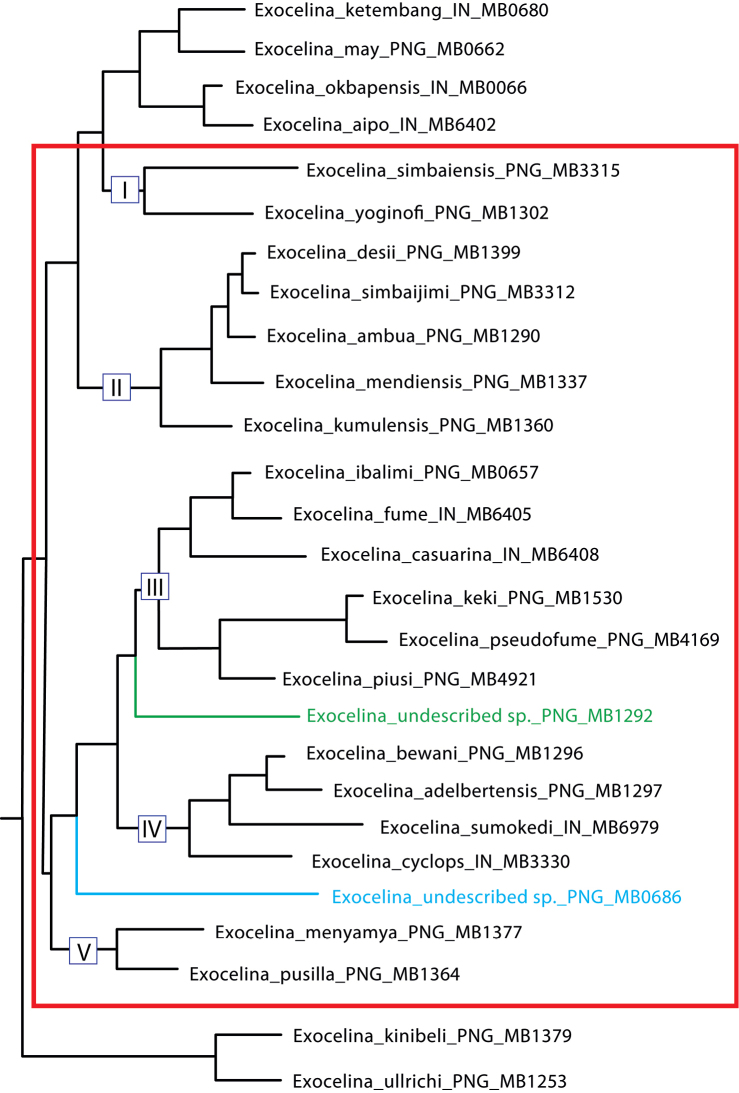
Phylogenetic relationships of the Exocelinacasuarina-group based on the MrBayes phylogenetic tree in figure S1 of Toussaint et al. (2015).